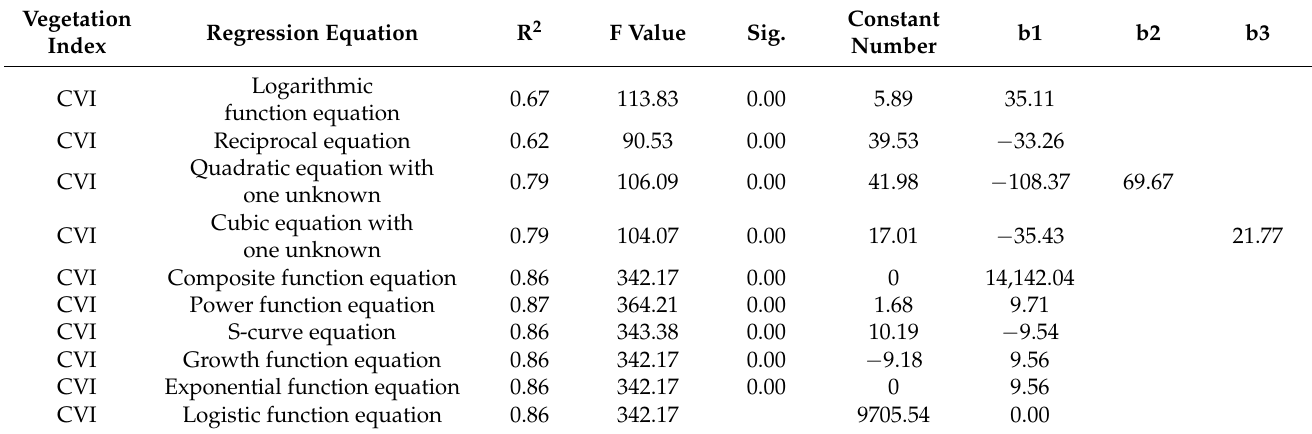
Table 5 indicates the results of regression simulation of the CVI and 3D-GSQP and the main forms of non-linear model equations. Among them, the accuracy of the power function equation, S-curve equation, growth function equation, and exponential function equation is high, and their corresponding R 2 values are 0.87, 0.86, 0.87, and 0.86, respectively. The composite function equation and logistic function equation also have high accuracy; however, their constant numbers and b1 values are prominent, and they are not